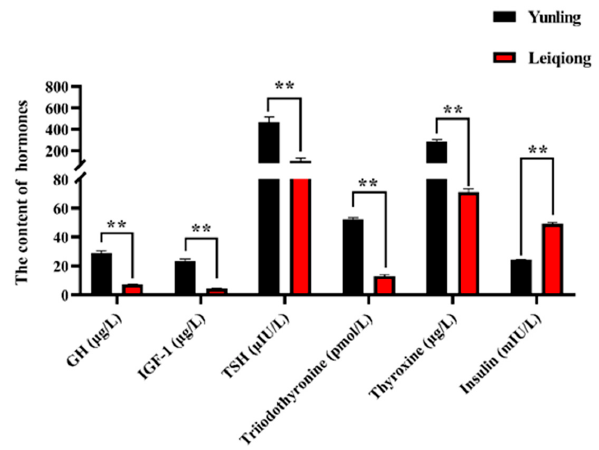
Figure 1. The concentration of hormones in the plasma of the two breeds (the black columns are Yunling cattle and the red columns are Leiqiong cattle, ** p < 0.05). Yunling cattle and the red columns are Leiqiong cattle, ** p <